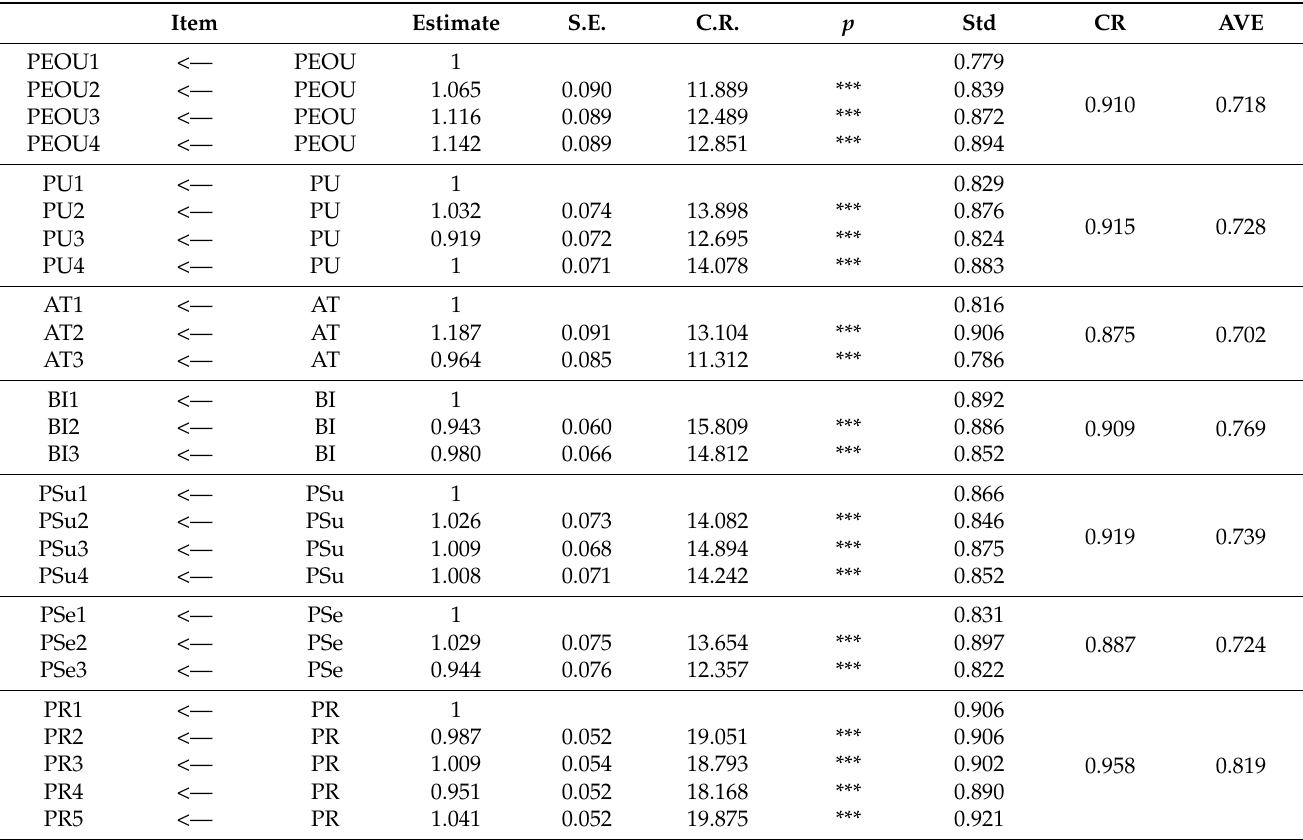
Table 6. Summary table of confirmatory factor analysis.